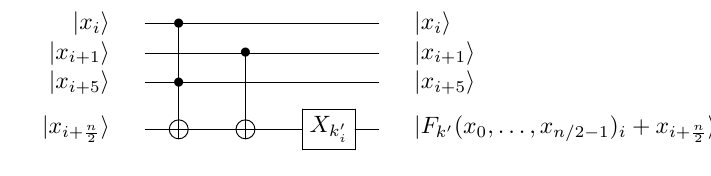
Figure 5: In-place realization of F k 0 ( x ) i , i < n